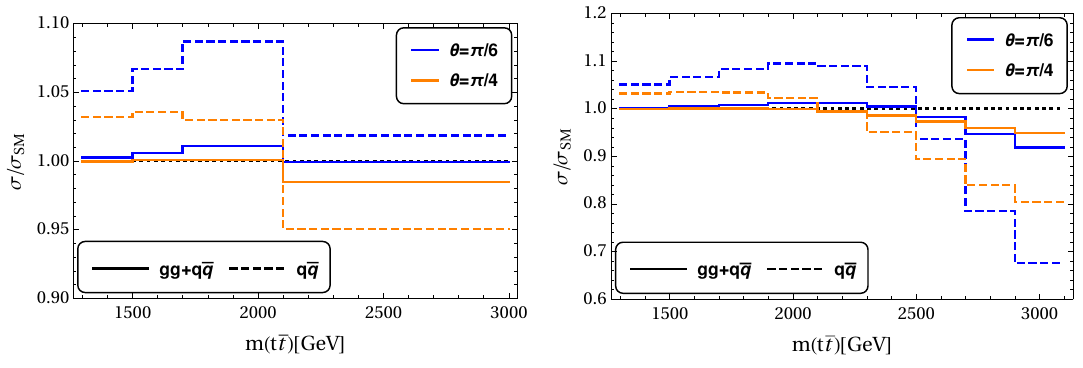
Figure 7 . Cross section for pp ! t (cid:22) t normalized to the SM as function of center of mass energy in the partially composite case. Values of parameter used: (cid:21) = 3, f = 0 : 6 TeV, (cid:20) = 2, m D = 5 f , M = 9 f and (cid:3) T = 11 f